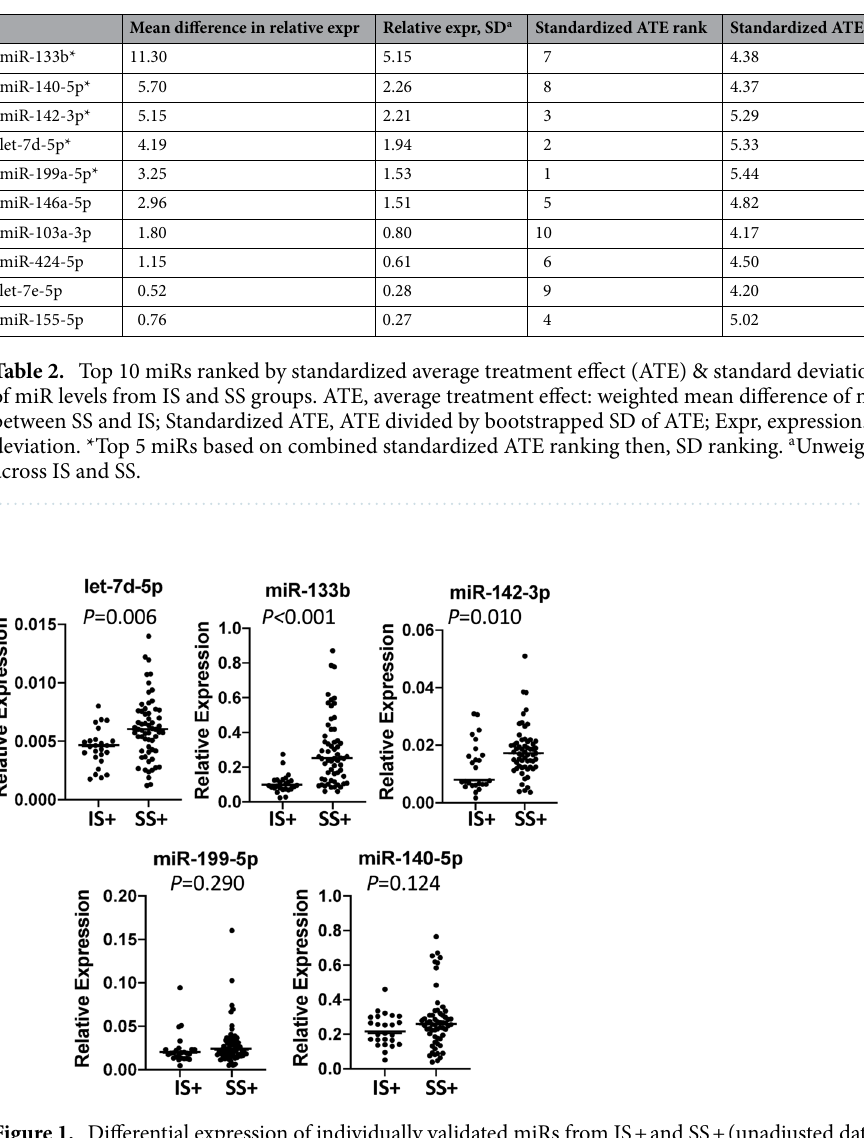
Figure 1. Differential expression of individually validated miRs from IS + and SS + (unadjusted data). The highest ranking 5 cardiovascular disease (CVD)-related EC-EV miRs initially identified in pooled RNA sample sets from IS and SS were validated by qPCR in individual RNA samples. IS + : Interrupted Sitter group with enhanced ethnic diversity (N = 25); SS + : Super Sitter group with enhanced ethnic diversity (N = 60). Statistical significance between IS + and SS + groups was examined by unadjusted t-test. Horizonal bars indicate group